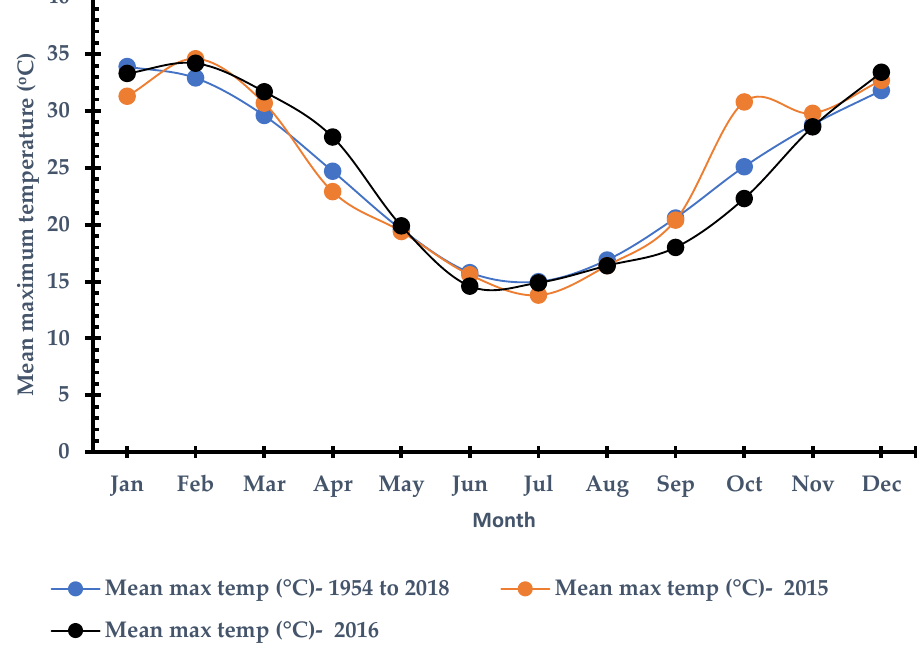
Figure 4. Condobolin mean maximum temperature for 2015 to 2016 (050052 Condobolin Agricultural Research Station, Australian Bureau of Meteorology).